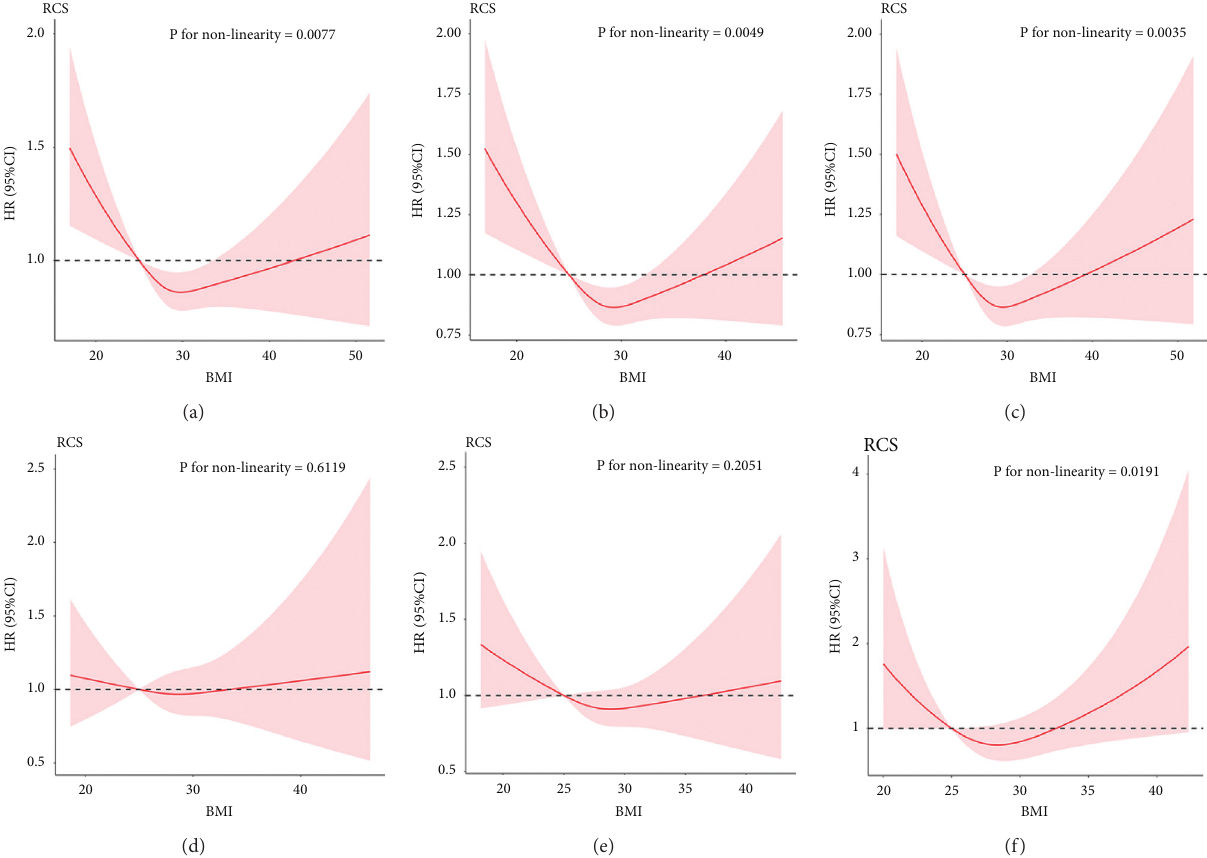
Figure 5: Sensitivity analysis of (1) excluding patients who died within 30 days after the CABG (a) and PCI (d); (2) excluding patients who had abnormal BMI values of CABG patients (b) and PCI patients (e); (3) the complete data before performing multiple imputation of CABG patients (c) and PCI patients